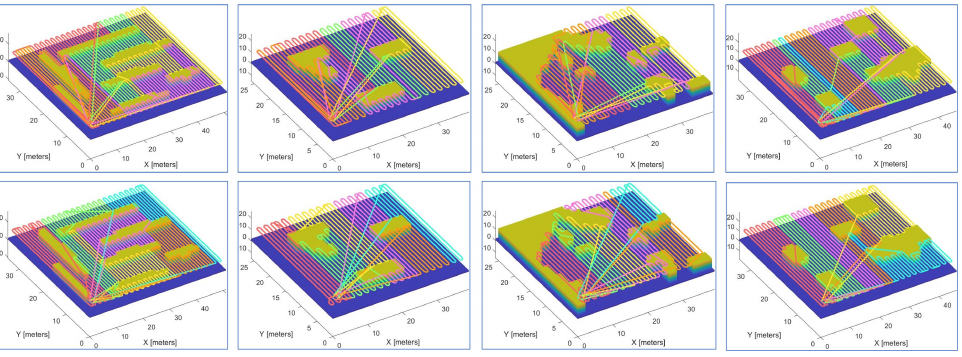
Figure 15. Coverage paths of DCRC ( first row ) and CDM ( second row ) with six robots.